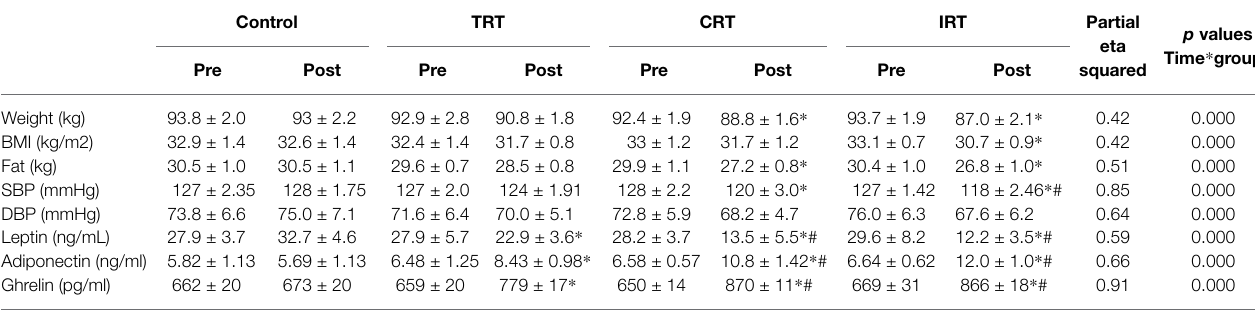
p values eta Time * group squared